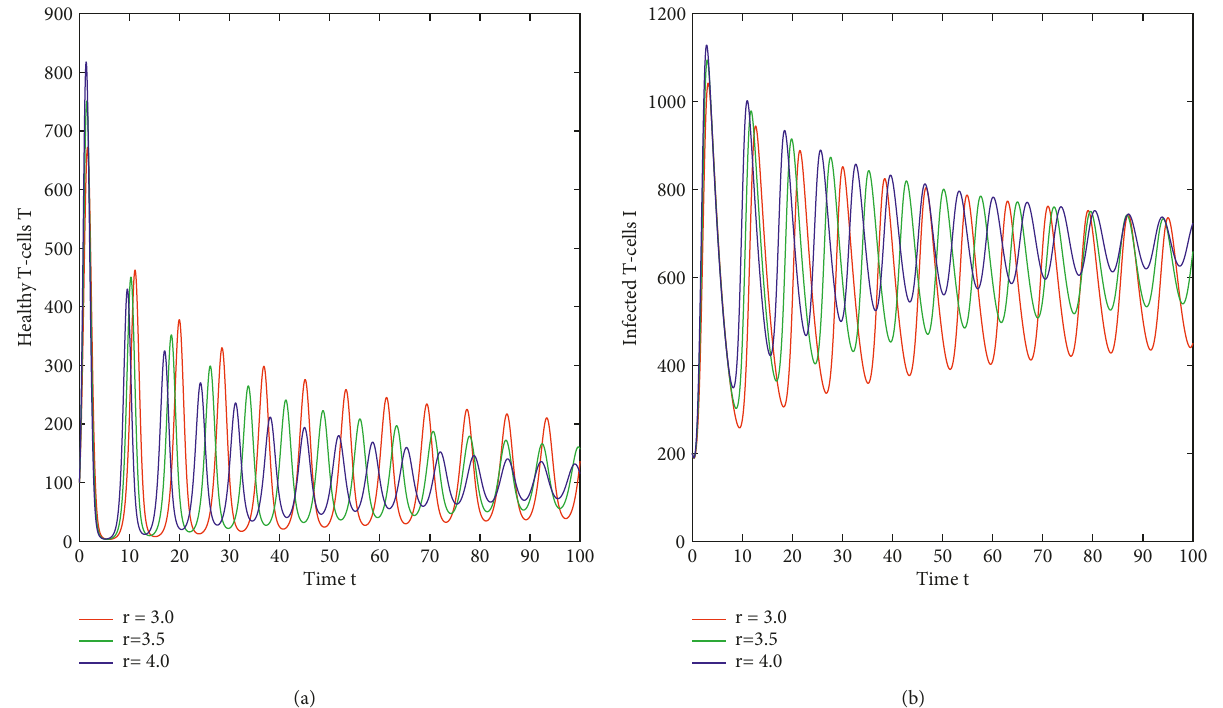
Figure 9: Graphical view analysis of the suggested fractional model (2) of HIV with the variation of r , i.e., r � 3.0, 3.5, 4.0.